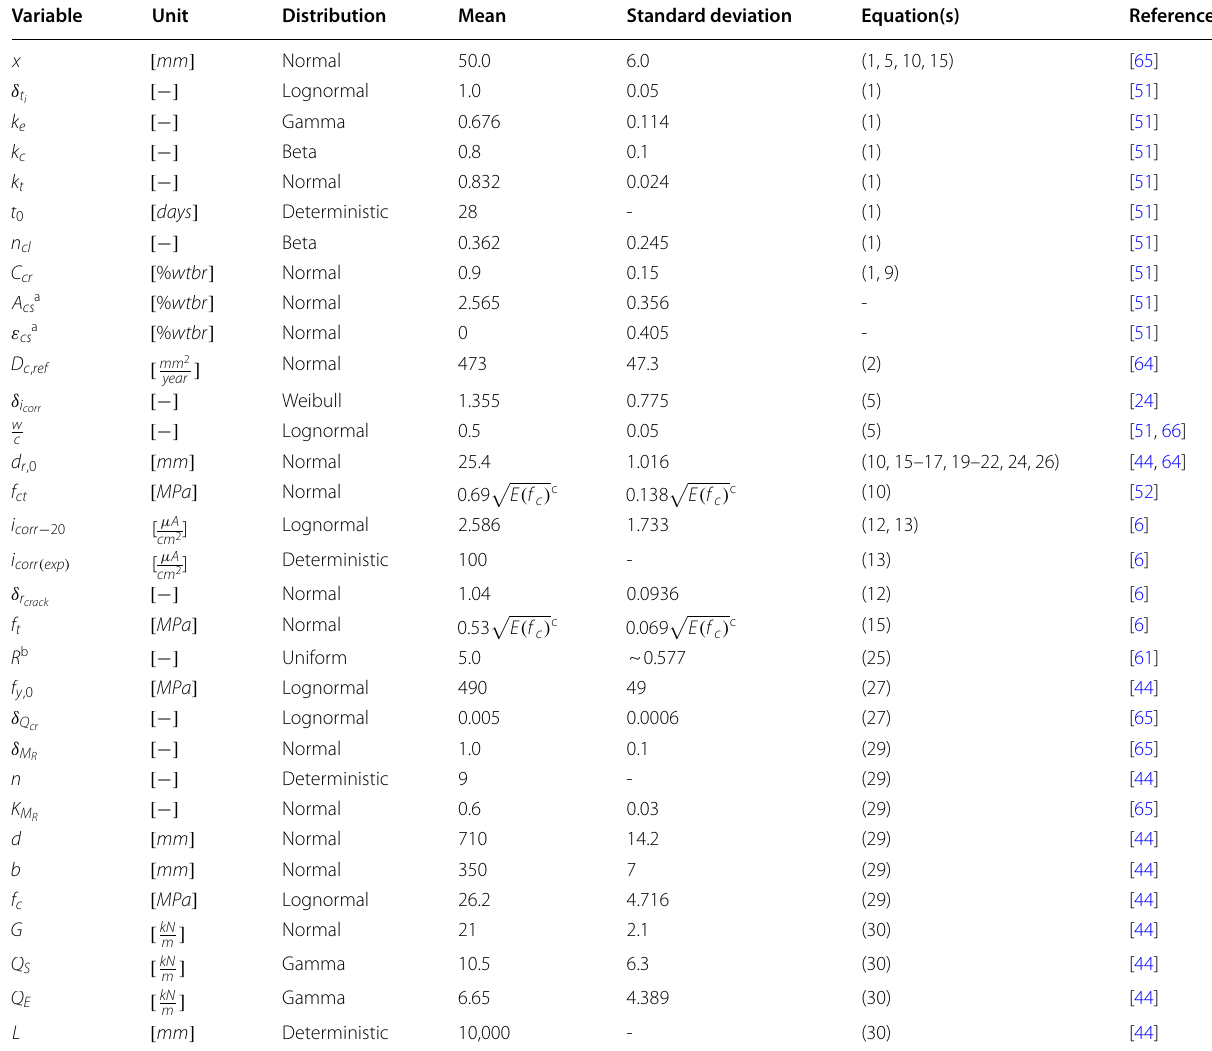
Table 1 Variables considered in the illustrative